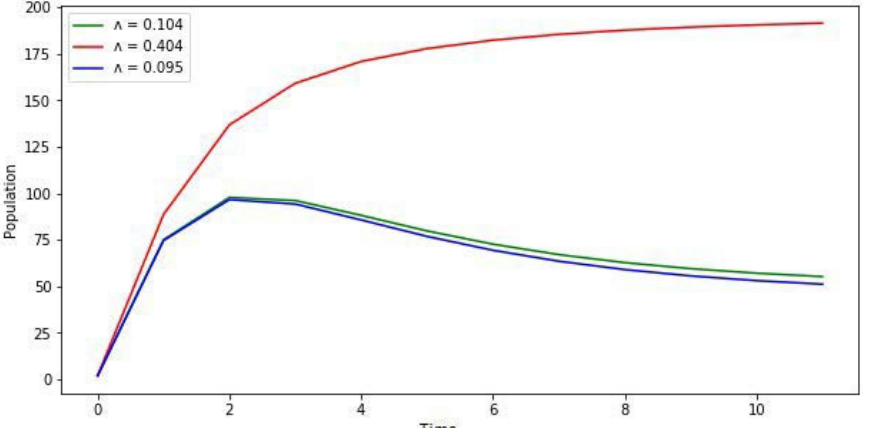
Figure 7. Progression of the infected individuals according to the parameter Λ . Blue color: Λ = 0.095, blue color: Λ = 0.104, and red color: Λ = 0.404.